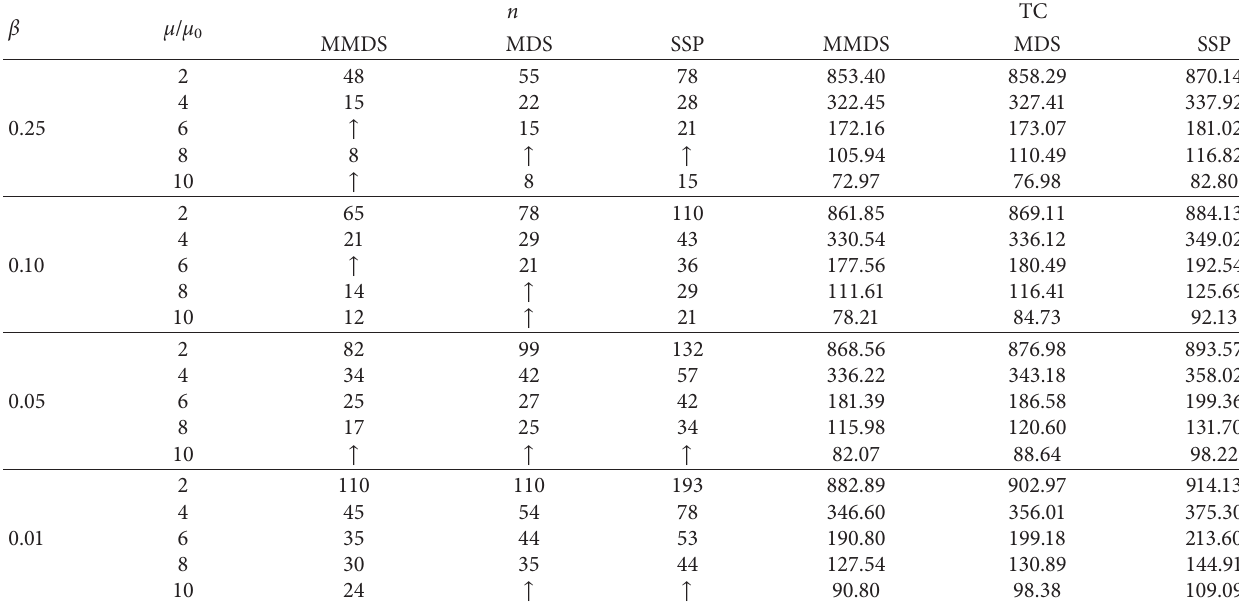
Table 9: Sample size and TC for proposed plan, MDS sampling plan, and